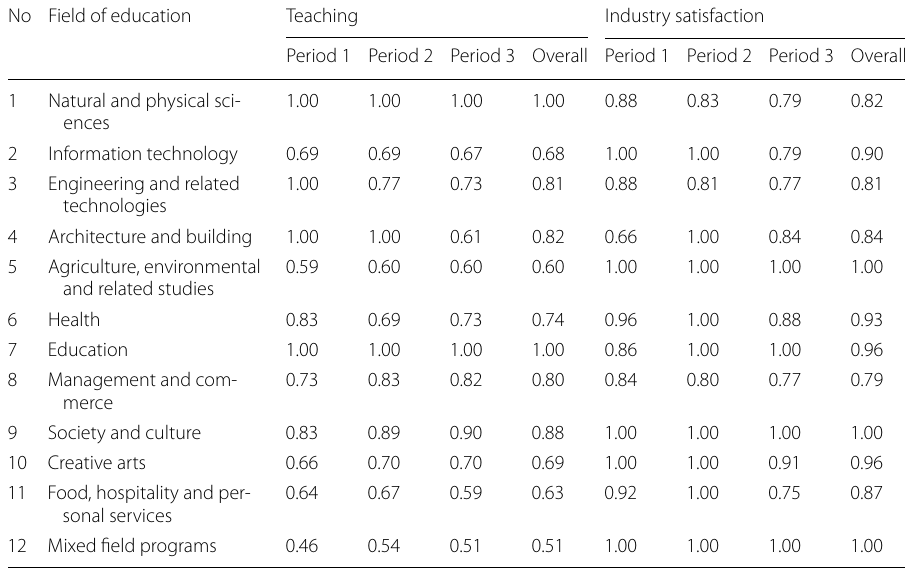
Table 9 Divisional efficiencies of teaching and industry responsiveness over the reported periods No Field of education Teaching Industry